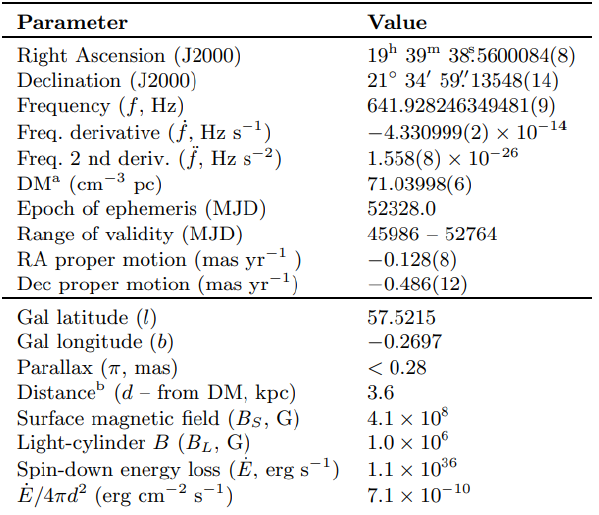
Table 2. Summary of the LEAP observation of PSR